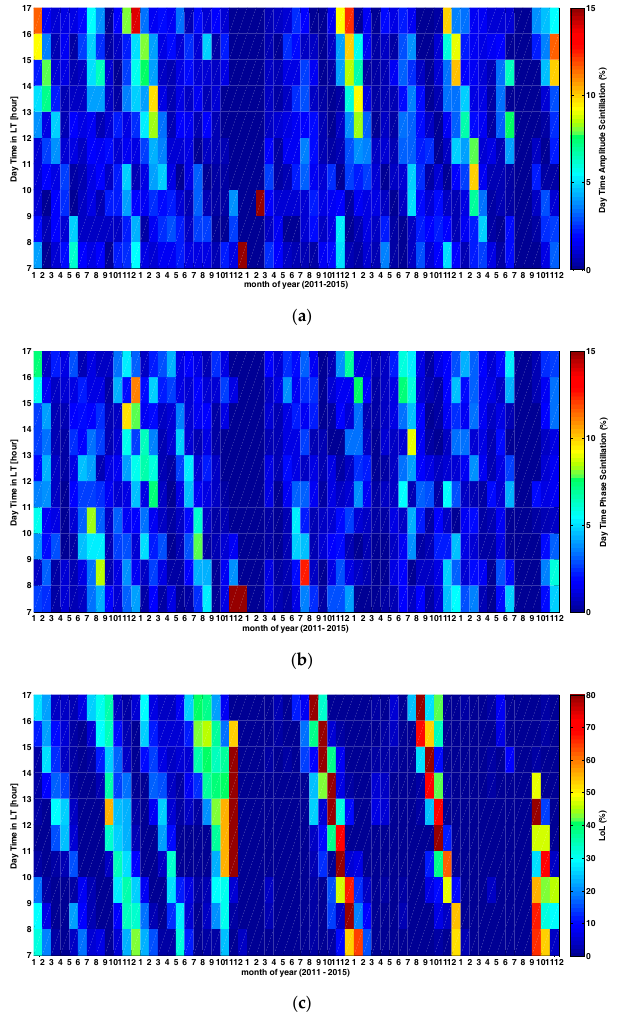
Figure 4. ( a ) Daytime amplitude scintillation percentage; ( b ) Daytime phase scintillation percentage; ( c ) Daytime loss of lock percentage by scintillation.